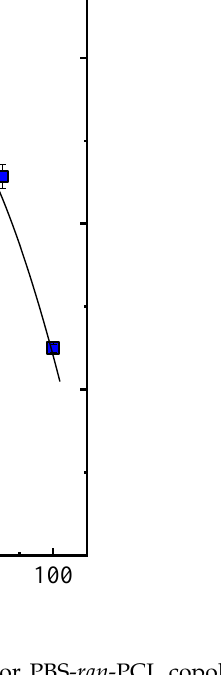
Figure 4. Activation energy of flow for PBS- ran -PCL copolyesters as a function of copolyester com- position.